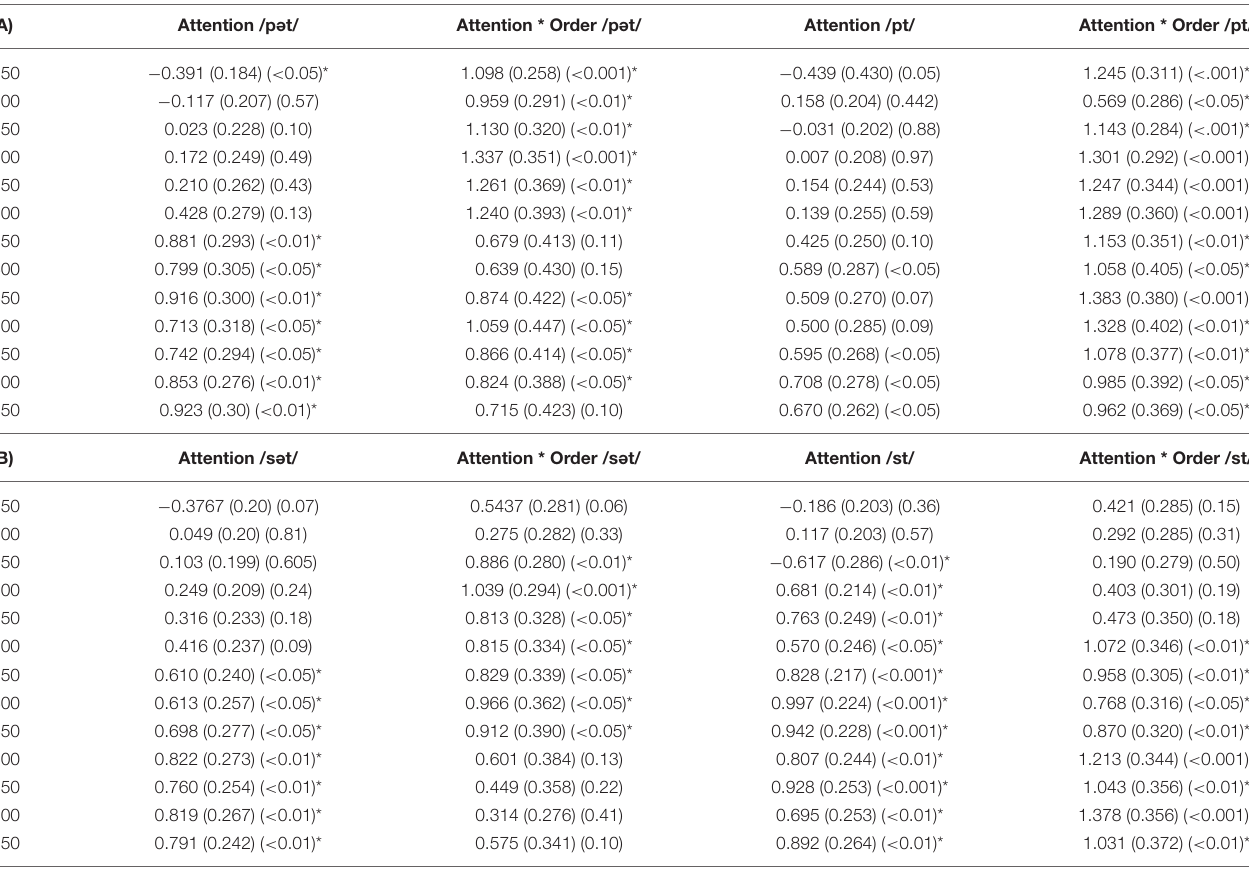
TABLE 2 | The significant main effects of attention and the significant interactions between attention and order for condition presentation (MEM random slope analysis) in response to (A) /pet/ and /pt/ word types between 250 and 900ms and (B) /set/ and /st/ word types between 350 and 900ms.